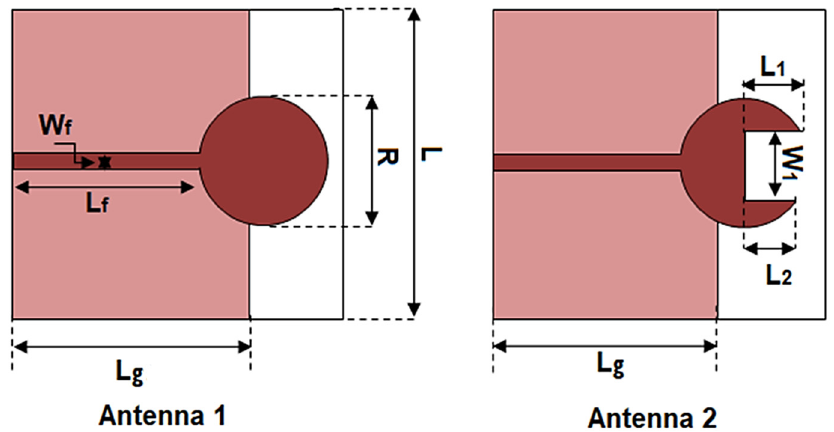
Figure 1. The evolution of a 38 GHz circular patch antenna.